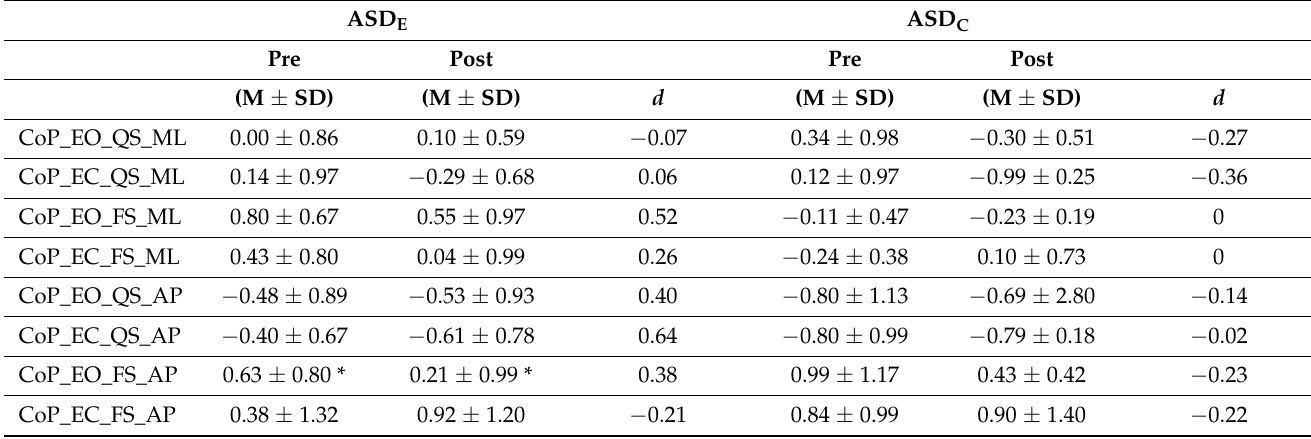
Table 6. Descriptive and statistical values of the CoP in the AP and